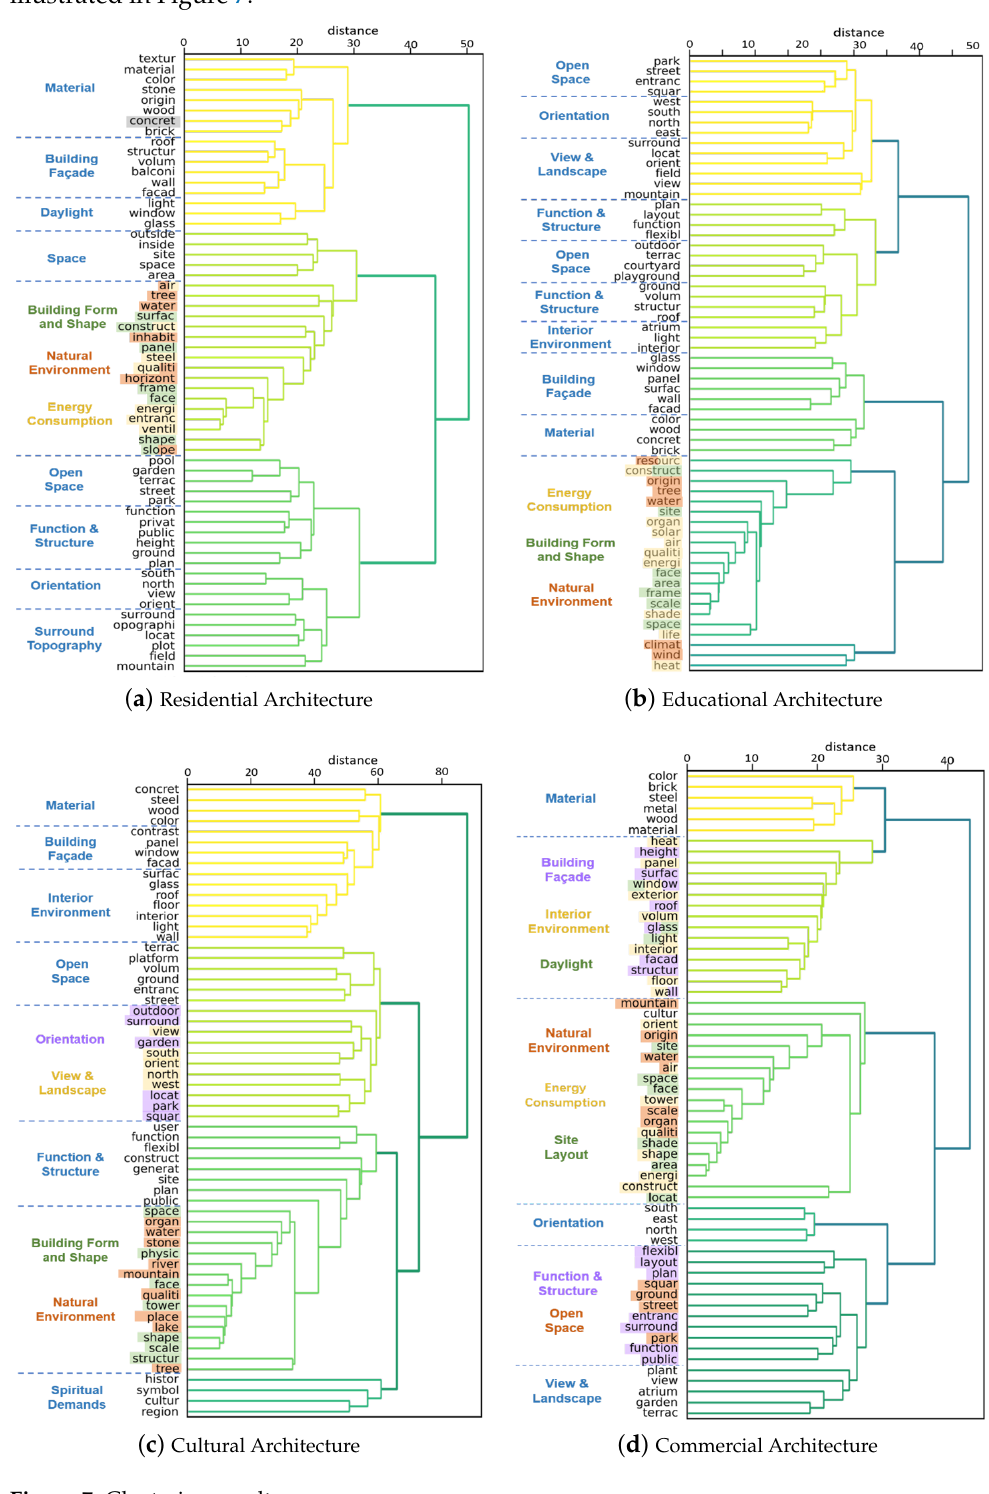
Figure 7. Clustering